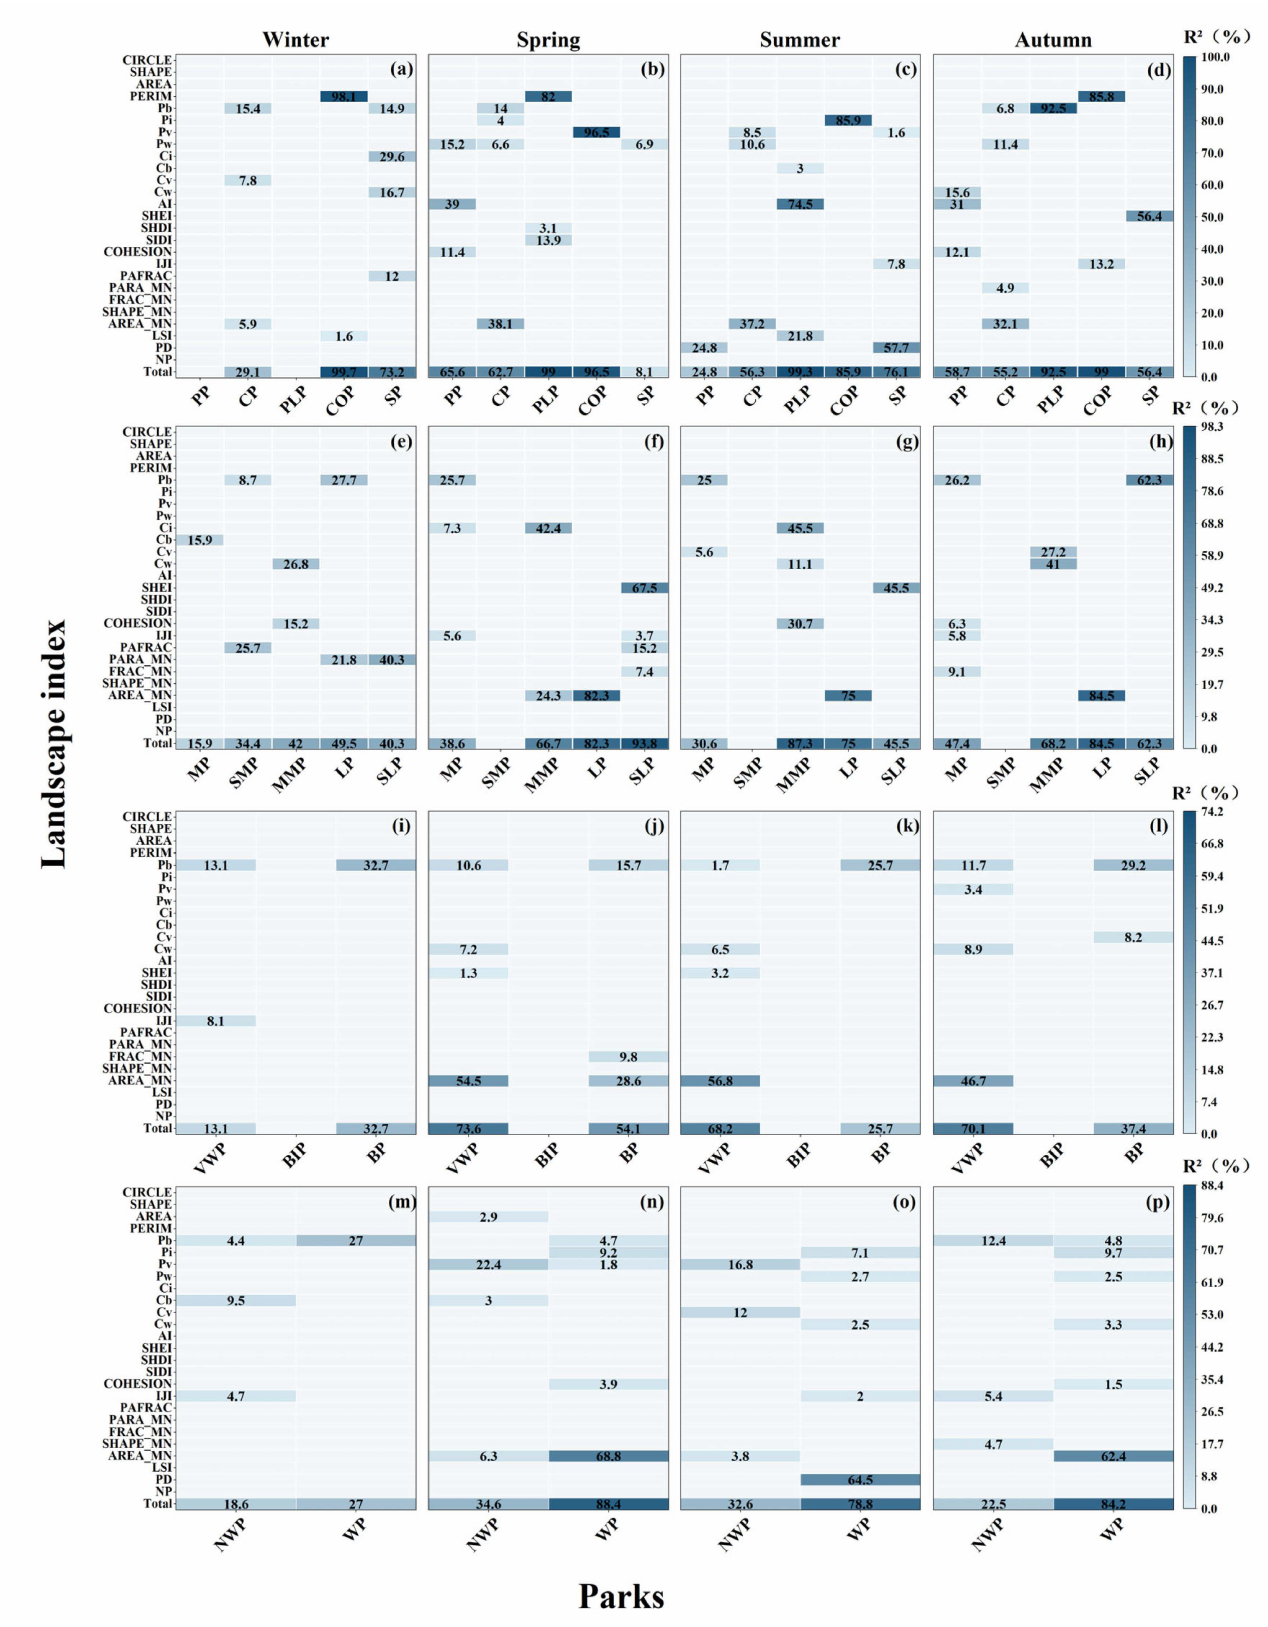
Figure 9. Stepwise regression diagram of landscape pattern and LST in different parks in four seasons ( a – p